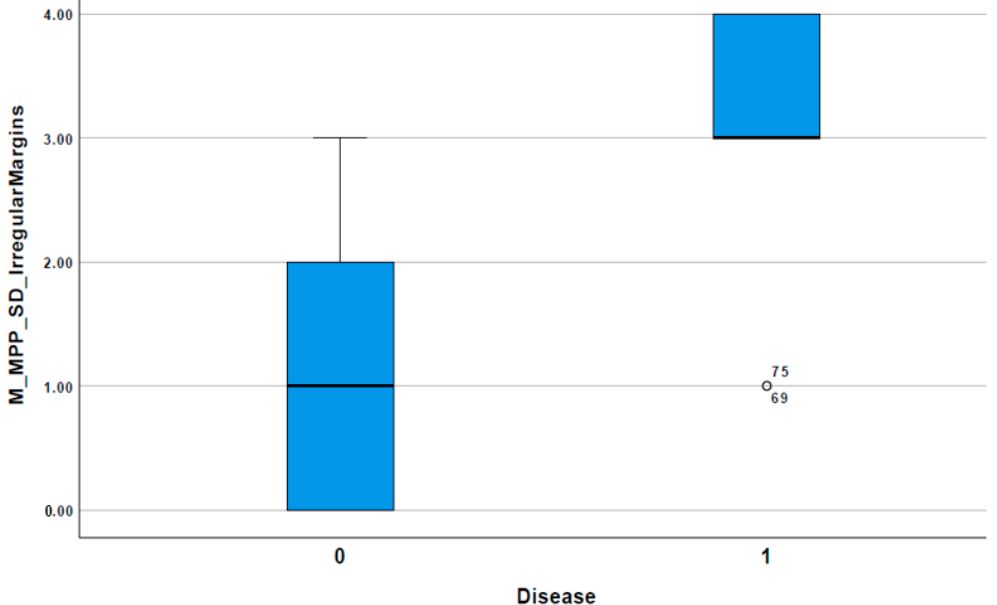
Figure 5. Composite score ≥ 3 identified the rapidly progressing HCC with a sensitivity of 81.8% and specificity of 81.8% (AUC = 0.884, p =